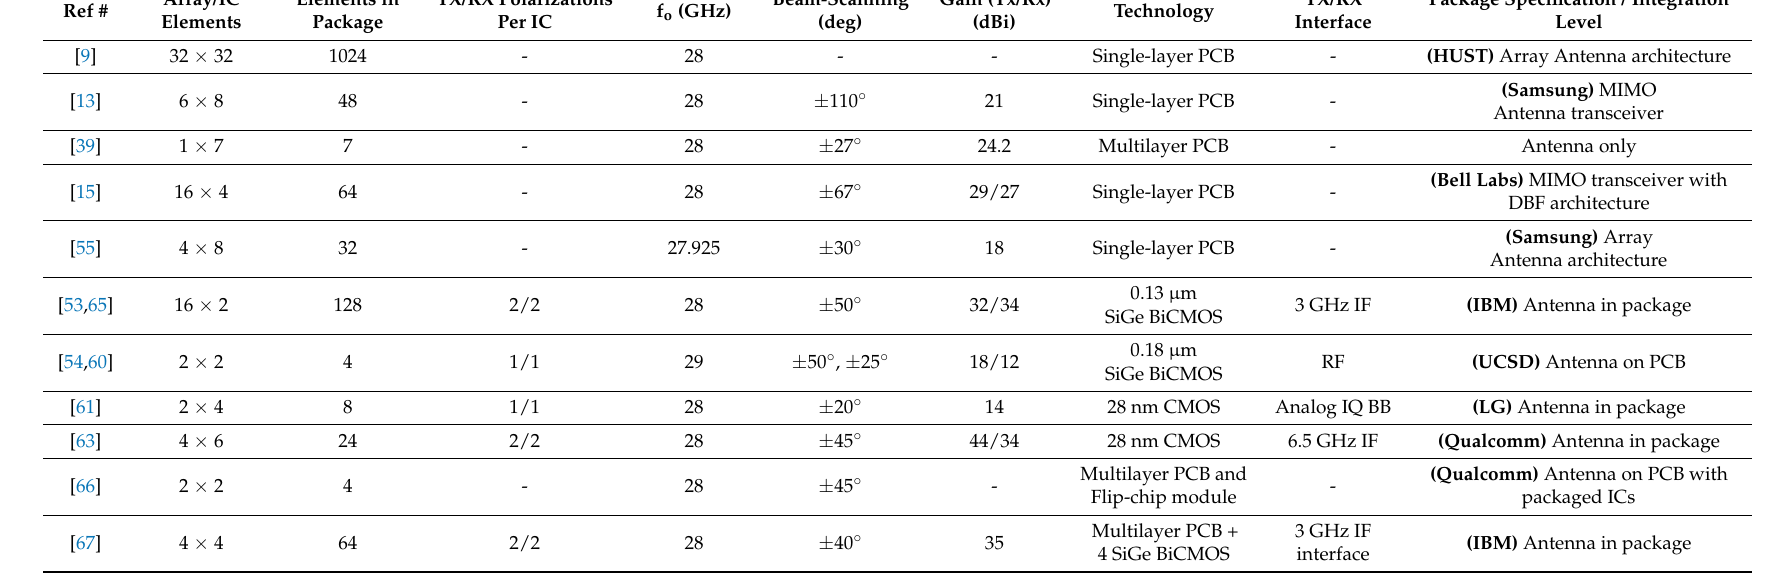
Table 2. Performance variation of various phased arrays for 5G access